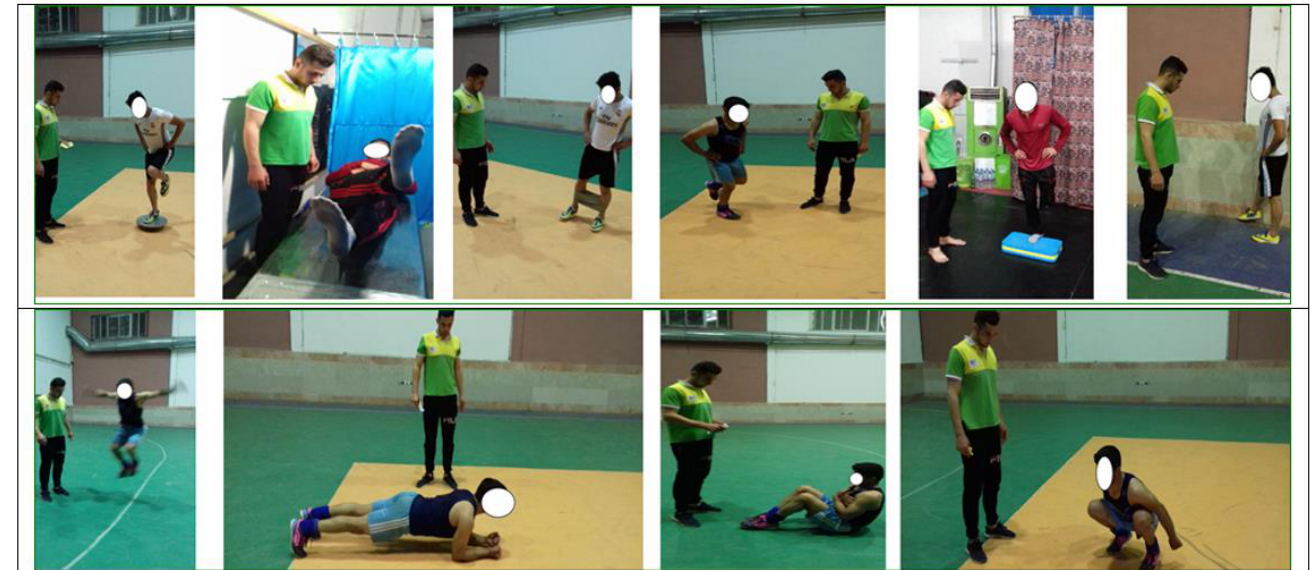
Figure 3. Examples of the balance plus strength exercises.